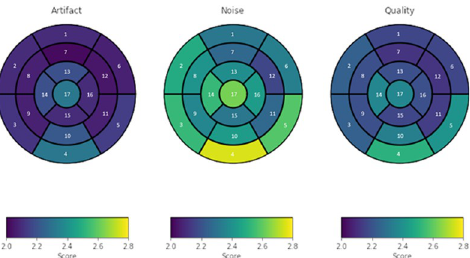
Fig 3. Left ventricular image quality of all 17 left ventricular segments. Representation of each quality parameter, artifact burden, noise, and overall quality as “bull’s eye”. The white numbers indicate the segment number. For each of these parameters, a score from 1 up to 4 was